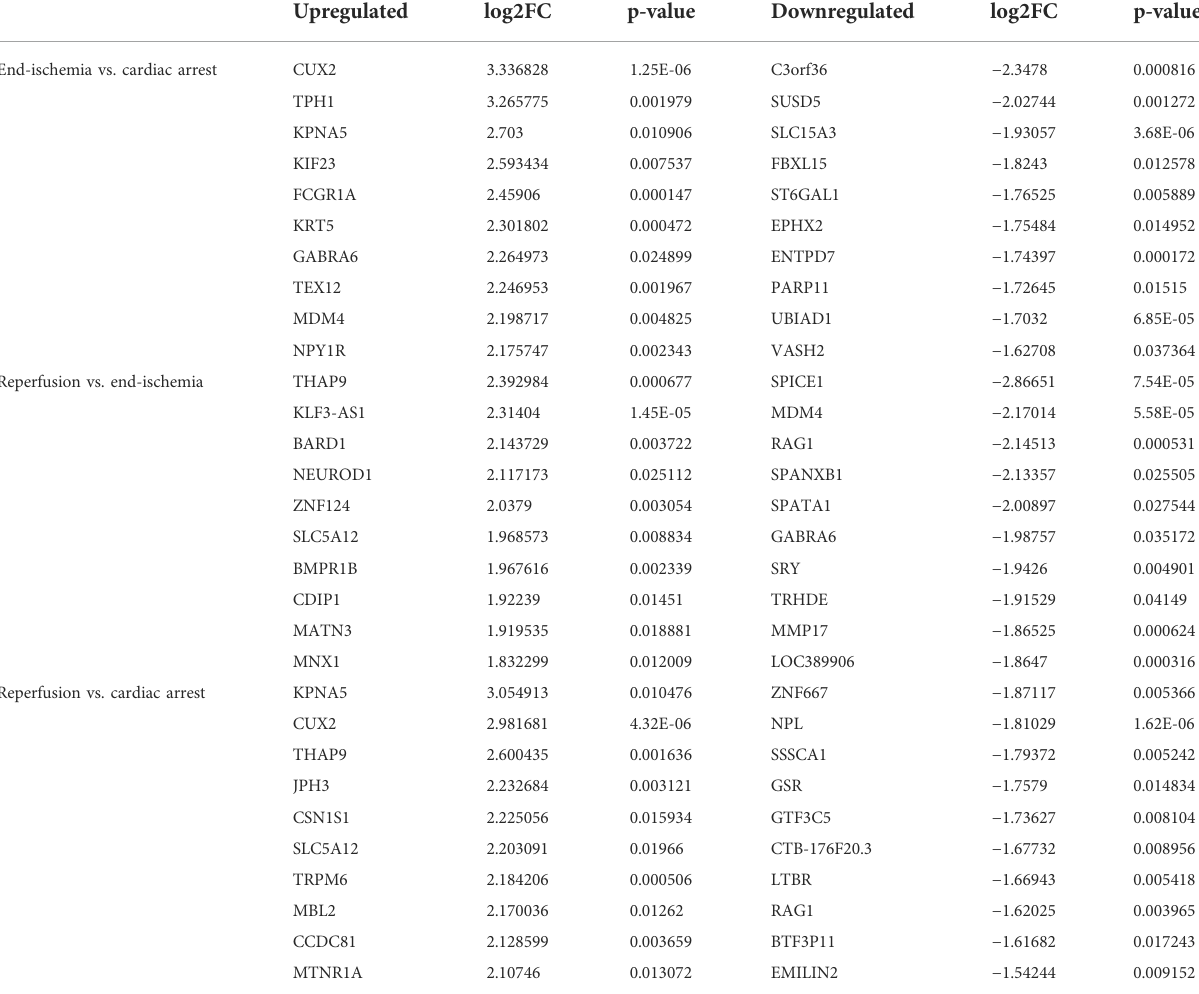
TABLE 2 Top 10 upregulated and downregulated DEGs for each comparison. Upregulated